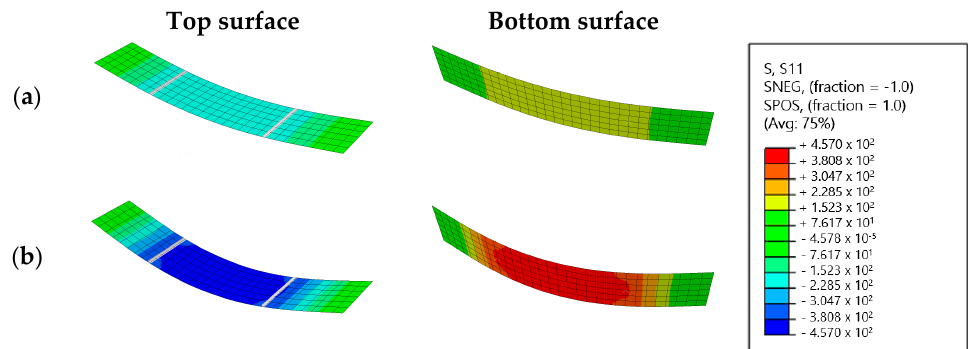
Figure 5. The 𝜎 (cid:3051) stress states of the top and bottom surfaces for a total load of ( a ) 1000 N and ( b ) 1800 N.